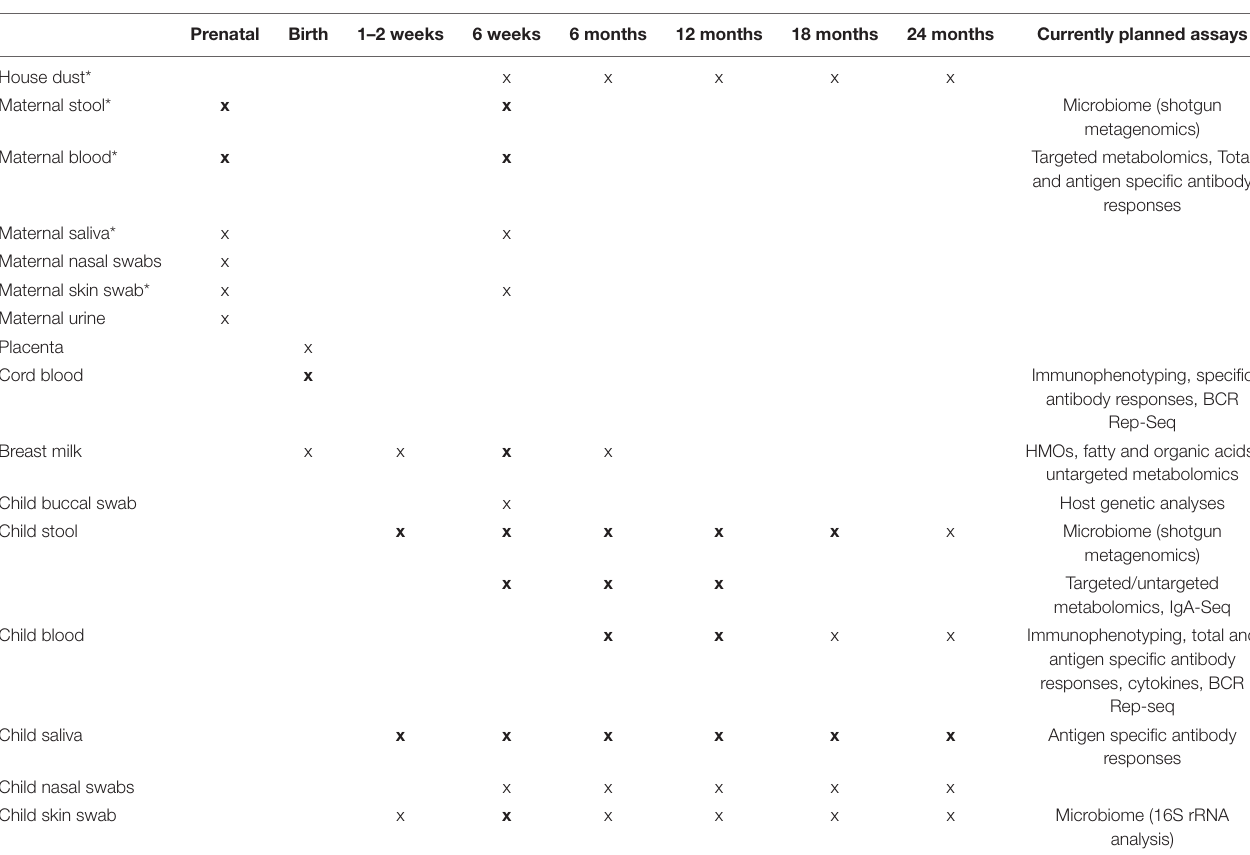
TABLE 1 | Sample collection schedule.